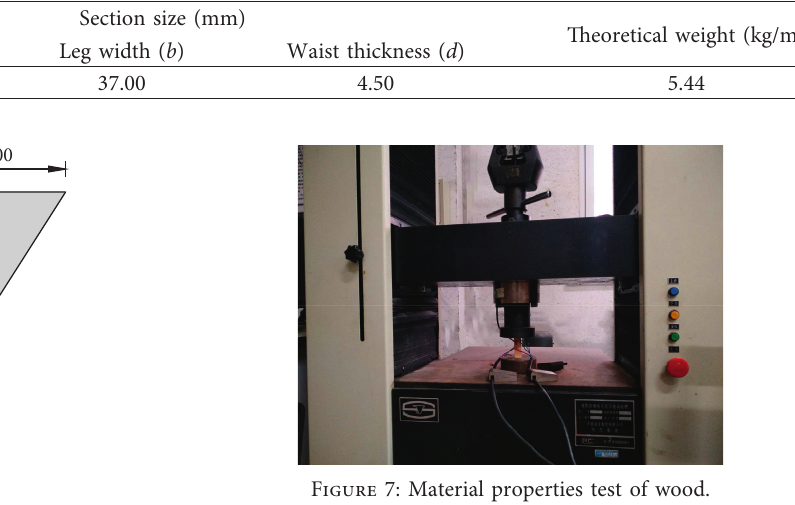
Table 1: Model and specification of channel steel.